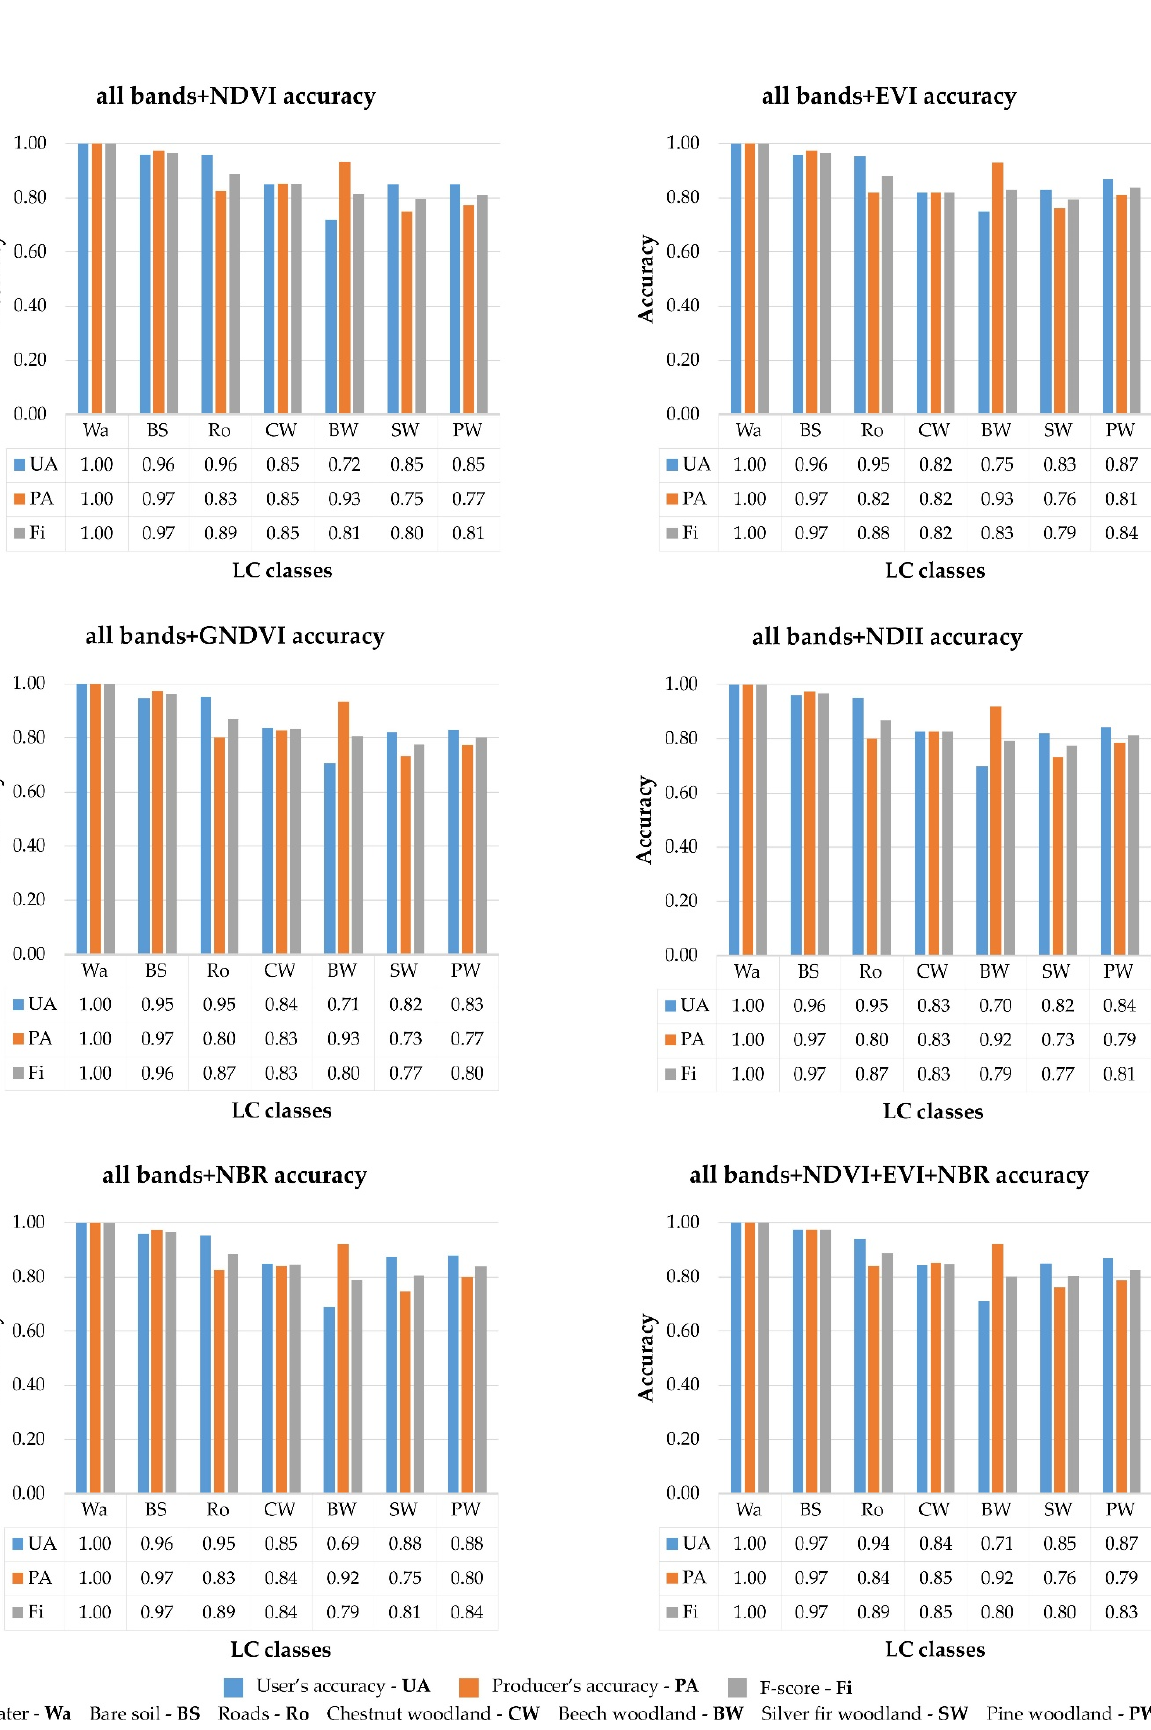
Figure A4. Bands with vegetation indices (VIs) composition accuracy values, according to the land ‐ cover (LC) classes considered.